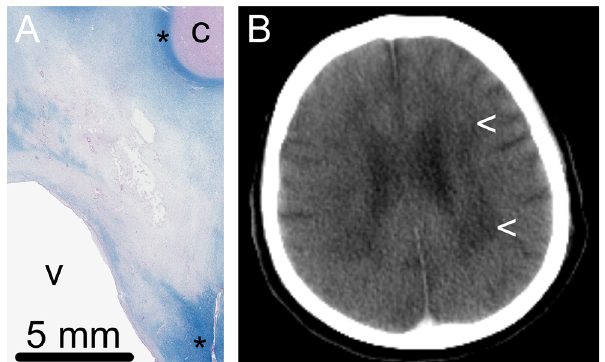
Fig. 4 Cerebral white matter lesions. a Histological slides (Luxol fast blue-Pas stain) showed dispersion of the matrix with extensive demyelin- ation in the central white matter. Normal myelination is seen subcortically and in the area around the basal nuclei (*). c = cortex, v = ventricle. b The CTscan of the patient showed nonspecific white matter abnormalities